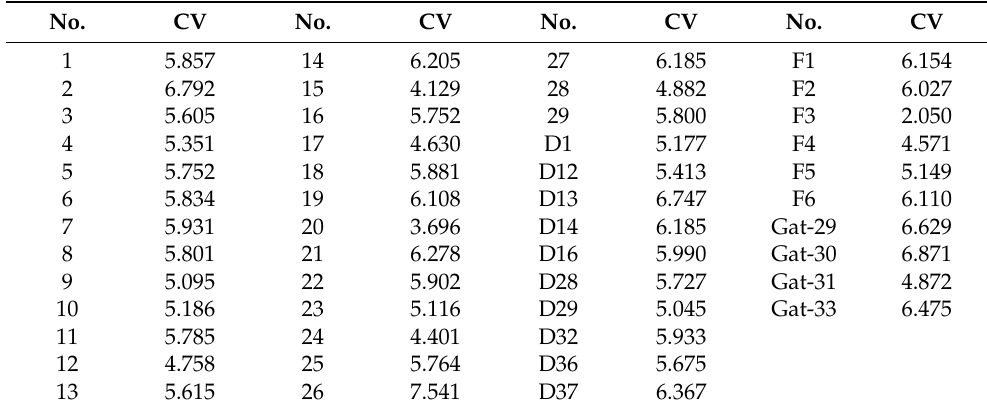
Table 3. Calculation of the comprehension value (CV) of combined biodegradation of 49 FQs by thermophilic group